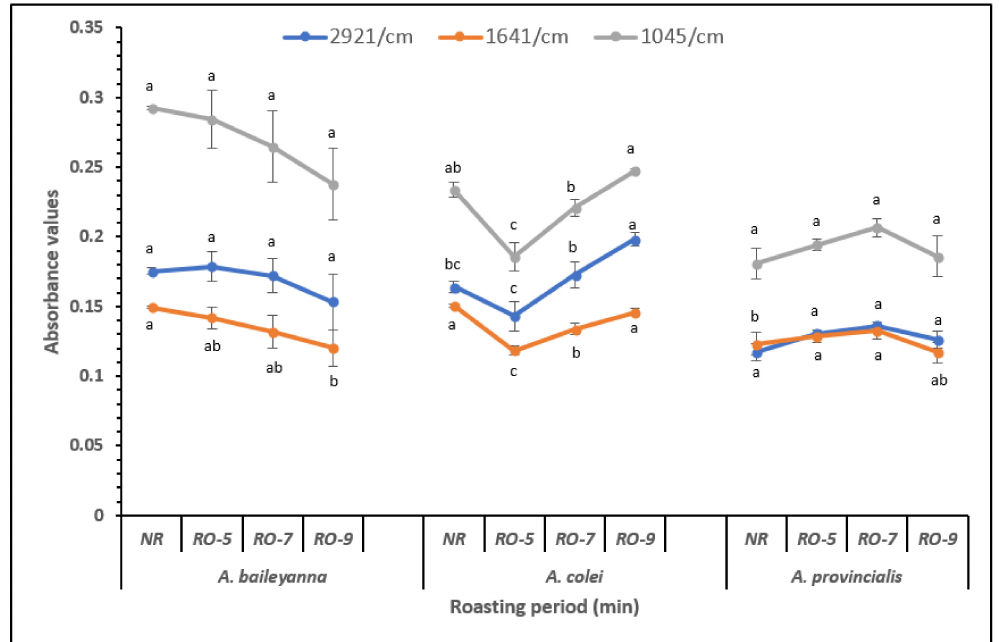
Figure 4. Absorbance values at specific wavenumbers derived from the analysis of acacia seed samples at different roasting periods (min) using mid-infrared spectroscopy. Means with the same letter are not significantly different ( p <